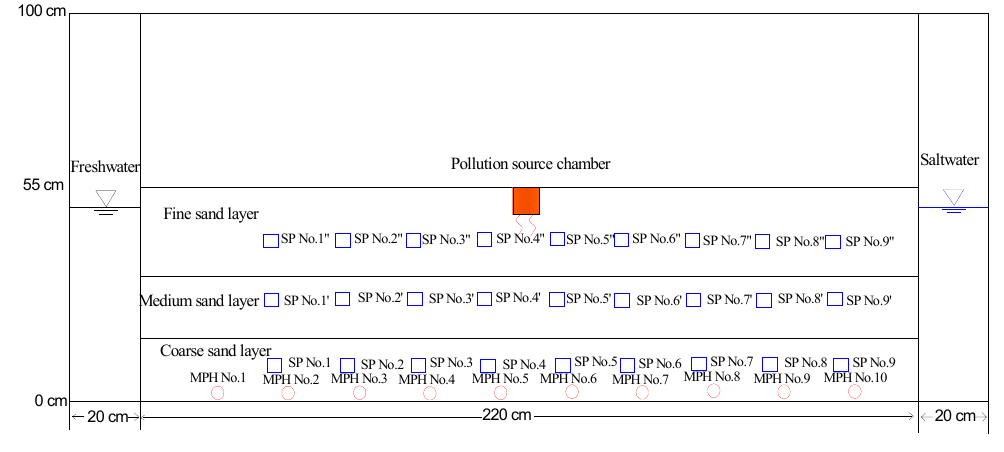
Figure 1. Schematic diagram of the test model.